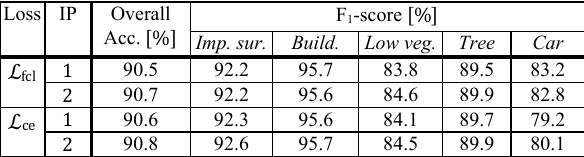
The models obtained by source training with Ω ∈ (cid:4670)Ω – , Ω (cid:3397) (cid:4671) are